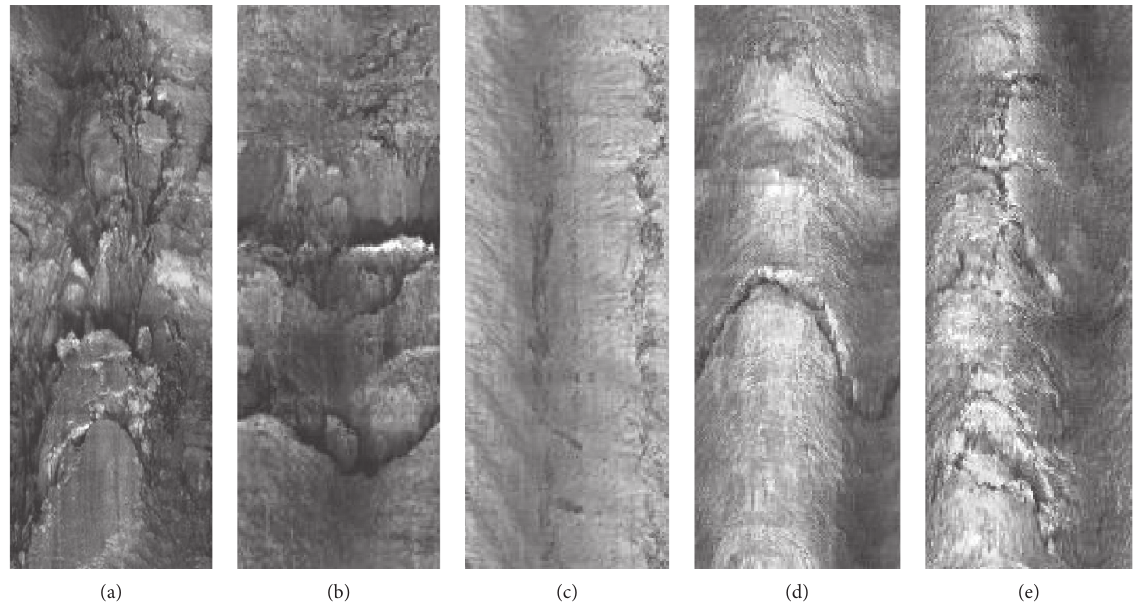
Figure 10: Crack types in the surrounding rock of the roadway: (a) crushing area; (b) circumferential crack; (c) longitudinal crack; (d) oblique crack; (e) various cracks.